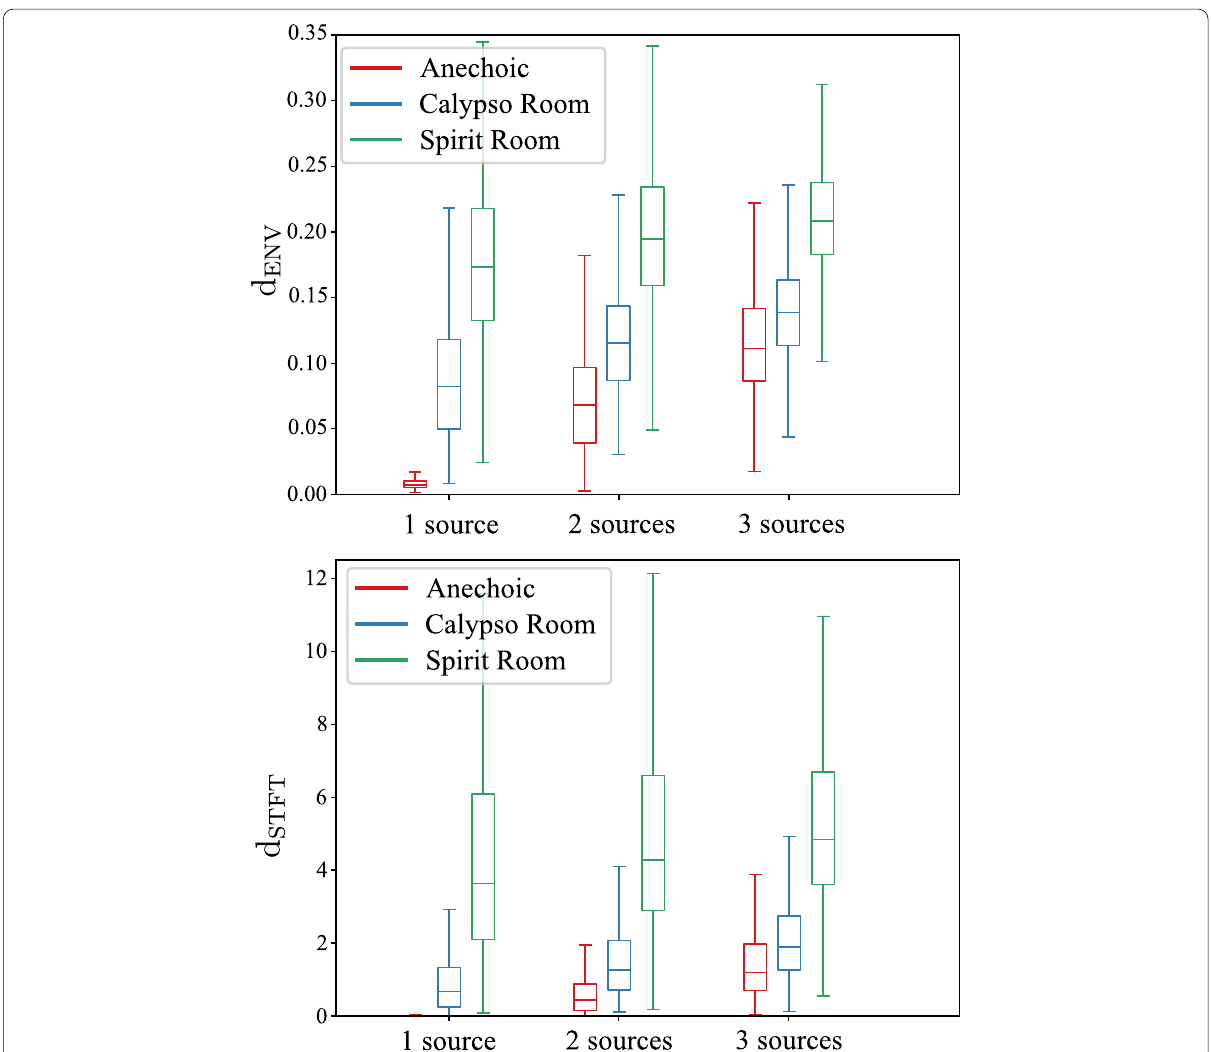
Fig. 4 Envelope Distance ( d ENV ) and STFT Distance ( d STFT ) of Points2Sound ( L full ), trained in anechoic conditions, for different rooms and number of sources in the 3D scene. The results are reported using rgb-depth point cloud features. For each number of sources, the box extension shows the first and third quartile of the data with a line at the median. The whiskers extending from the box show the range of the